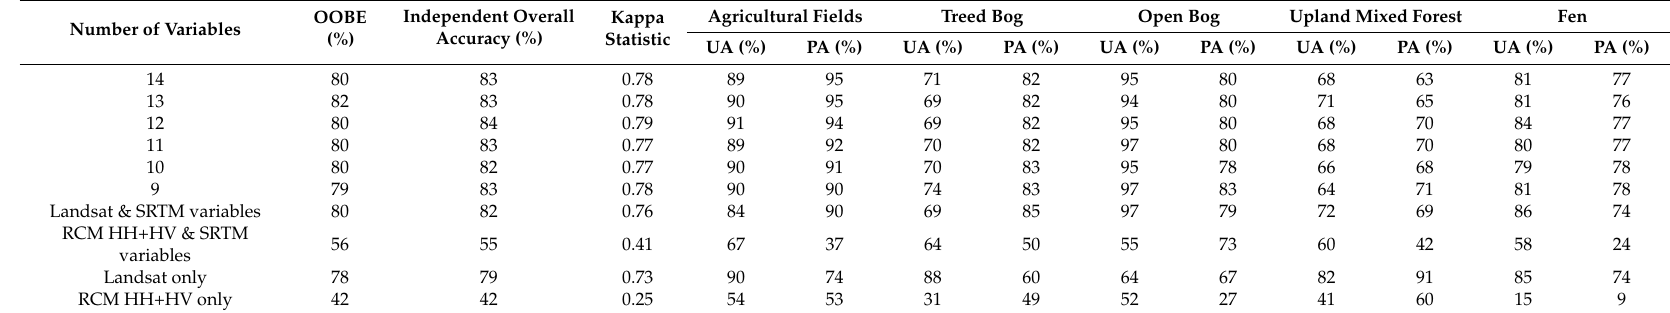
Table A4. Statistical results from the RCM Dual Pol HH+HV NESZ − 19 dB (2 May 2014), Landsat-8 (24 April 2014), and SRTM variables spring model. The first iteration was run with all 14 variables, and variables ranked to be unimportant were then removed until 9 variables remained. The final variables in the model with the highest independent overall accuracy (12 variables) in order of decreasing importance were the seven Landsat-8 bands, HH Intensity, HV Intensity, Total Power, HH/HV ratio, and SRTM DEM.